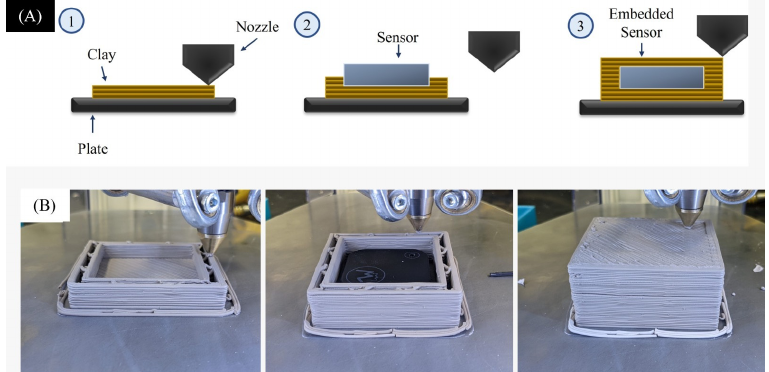
Figure 4. Schematic illustration of DIW printing with embedded sensor ( A ) and images of the embedded sensor printing stages ( B ).